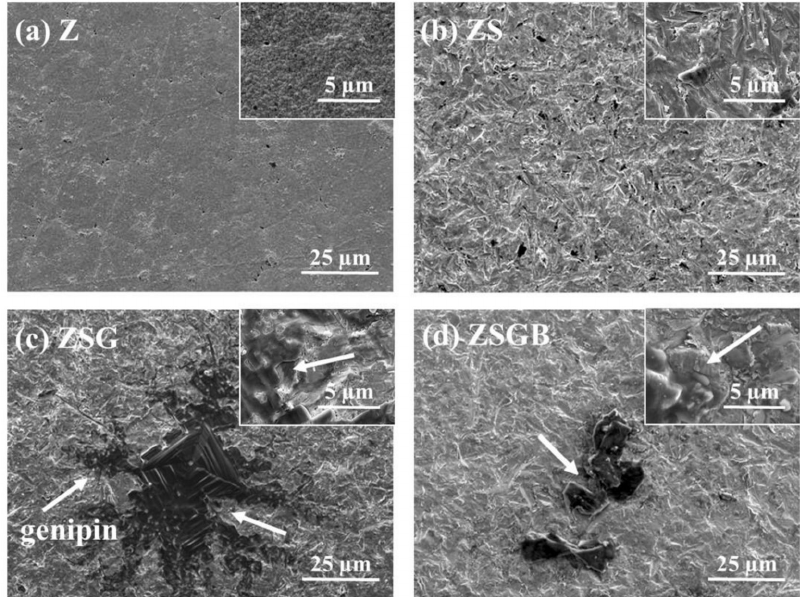
Figure 1. FESEM micrographs, showing the surface morphology of test specimens: ( a ) Z (untreated zirconia), ( b ) ZS (sandblasted Z), ( c ) ZSG (genipin-treated ZS), and ( d ) ZSGB (BMP-2-immobilized ZSG); the upper right corner of each figure is a partial enlarged view (arrows: genipin).